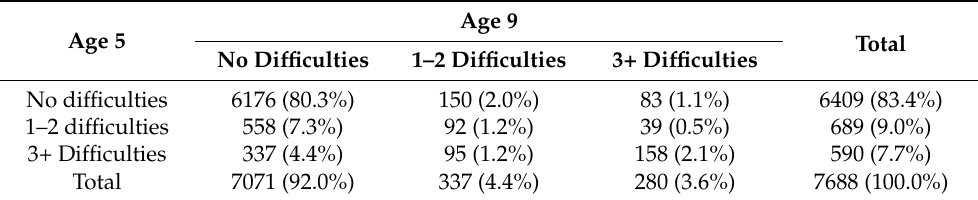
Table 2. The number and percentage of children by the number of speech and language difficulties reported when the children were 5 and 9 years